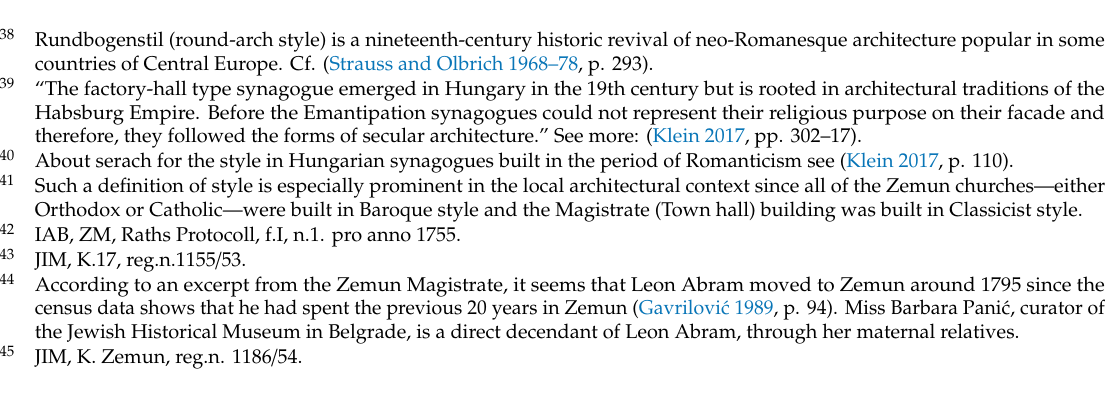
Figure 10. Inscription above the main entrance to the Zemun